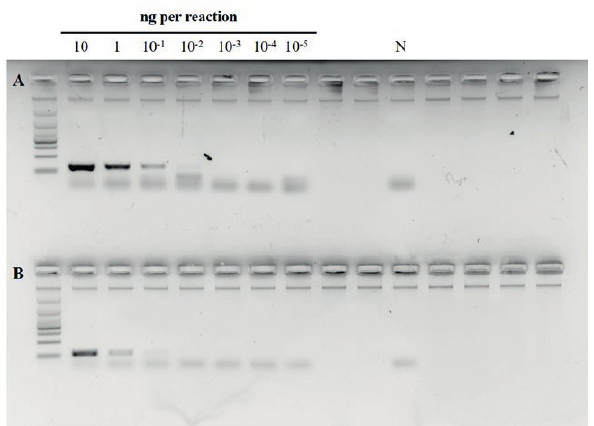
Figure 2. End-point polymerase chain reaction (PCR) analyti- cal sensitivity of the two primer sets with a 10-fold serial dilution at the indicated concentration of genomic DNA of Colletotrichum ocimi strain CVG190. A = primer set TubOc_68fw TubOc_197rev; B = primer set TubOc_23fw TubOc_190rev. N = negative control.